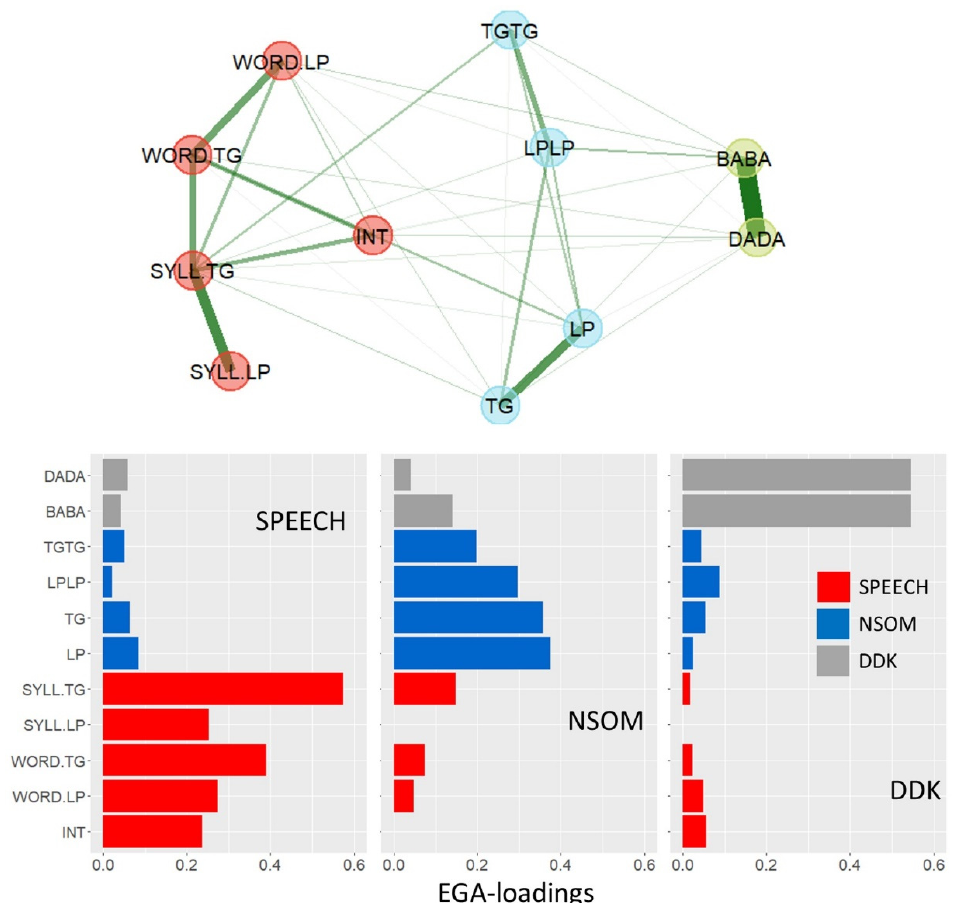
Figure 3. Exploratory graph analysis of assessment parameters specified for the involvement of labial vs. lingual gestures in the patient sample ( n = 130), together with intelligibility (INT). ( Top panel ): graphical solution; ( bottom panel ): EGA factor loadings. Red: Factor SPEECH; blue: factor NSOM; light green/grey: factor (syllable) DDK. CFA fit indices: CFI = 0.99, TLI = 0.99, RMSEA = 0.02 (“good” model fit; cf. Section 2.3).